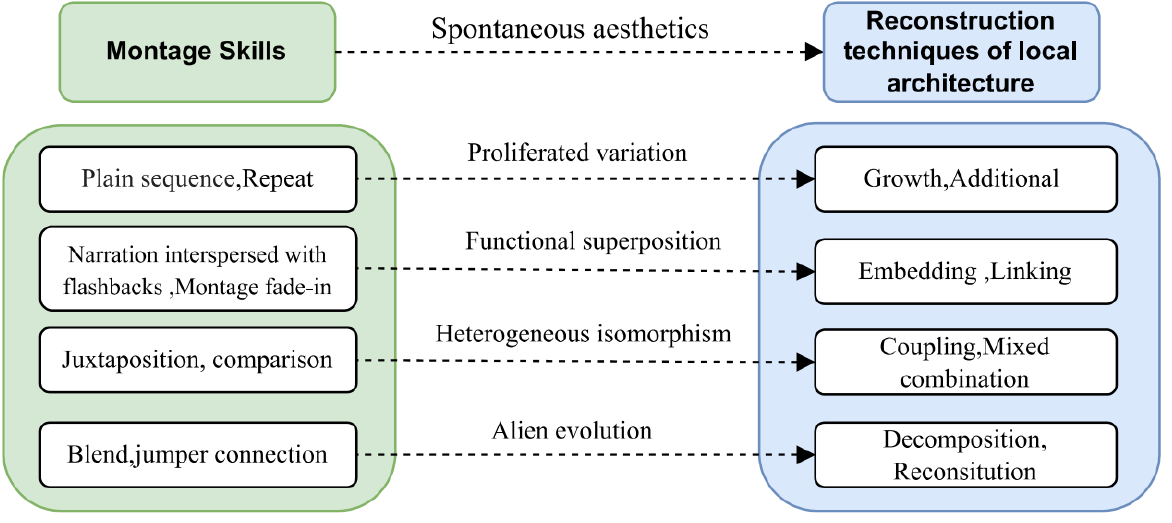
Figure 20. Montage skills and vernacular architecture renovation (source: the authors).